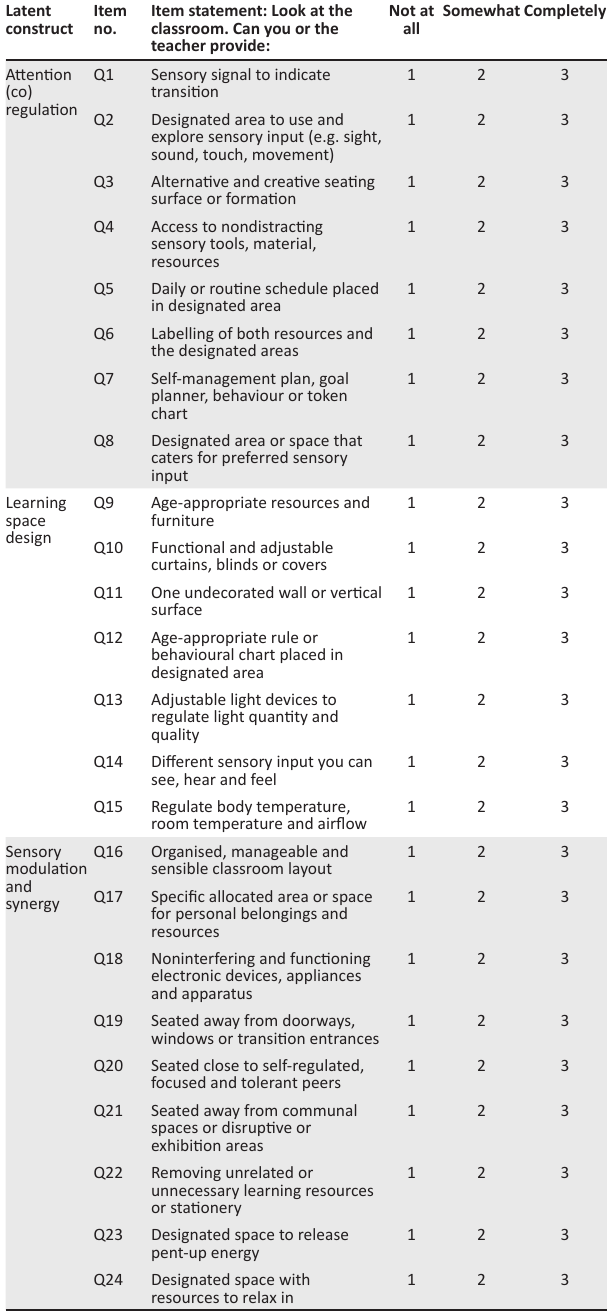
TABLE 2: The Sensory Classroom Teacher Questionnaire (Final version). Latent Item construct